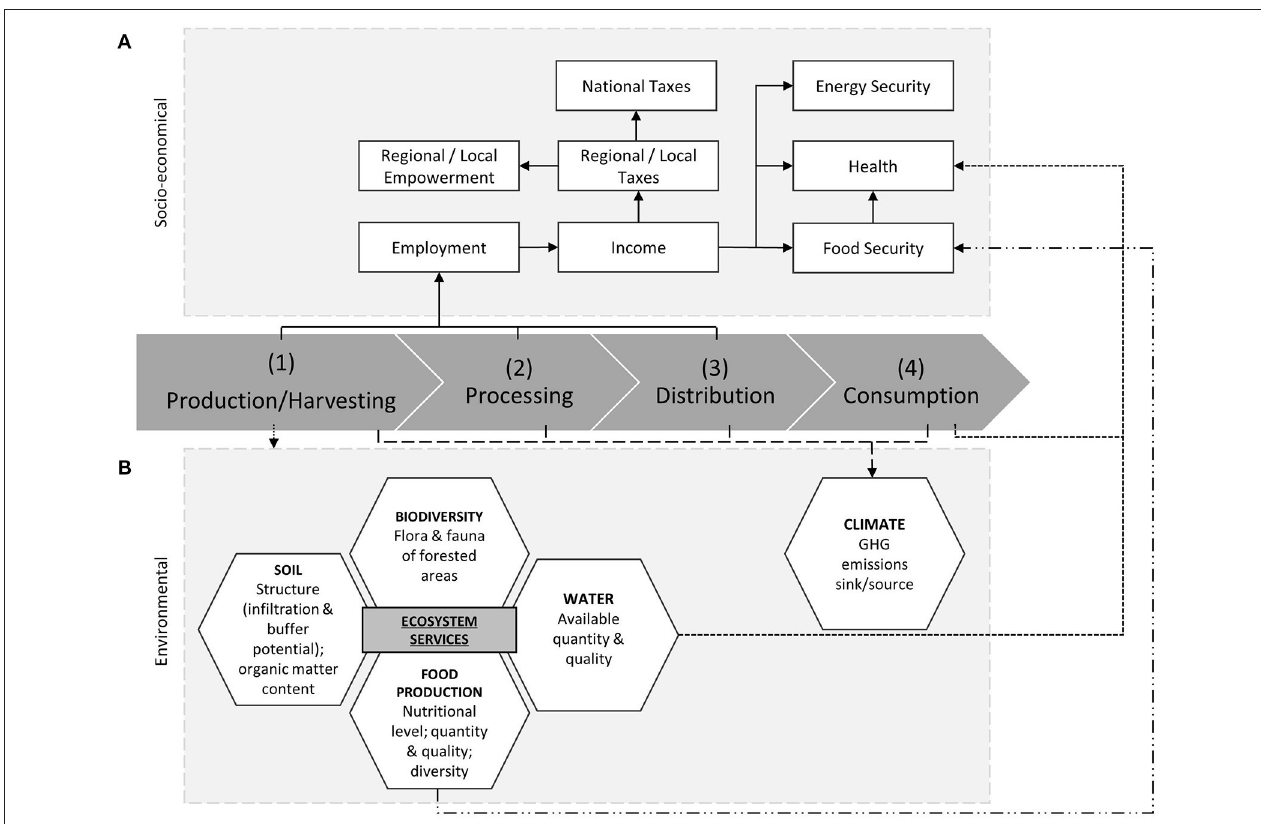
FIGURE 1 | Analytical framework for charcoal value chain assessment with focus on sustainability dimensions ( A : socio-economical; B : environmental) and WEF nexus analysis (adapted from Peter and Sander,